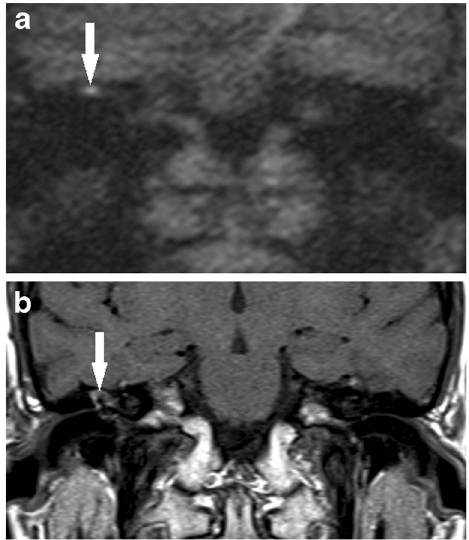
Fig. 10 False positive high DWI signal for cholesteatoma. a The coronal b1000 image shows high signal at the epitympanum, which raised suspicion for residual cholesteatoma. However, b the corresponding non-contrast enhanced coronal T1 weighted image showed high signal ( white arrow ) and the ADC map intermediate signal and value, both not supporting the diagnosis of cholesteatoma. Surgery confirmed non- specific inflammation with no